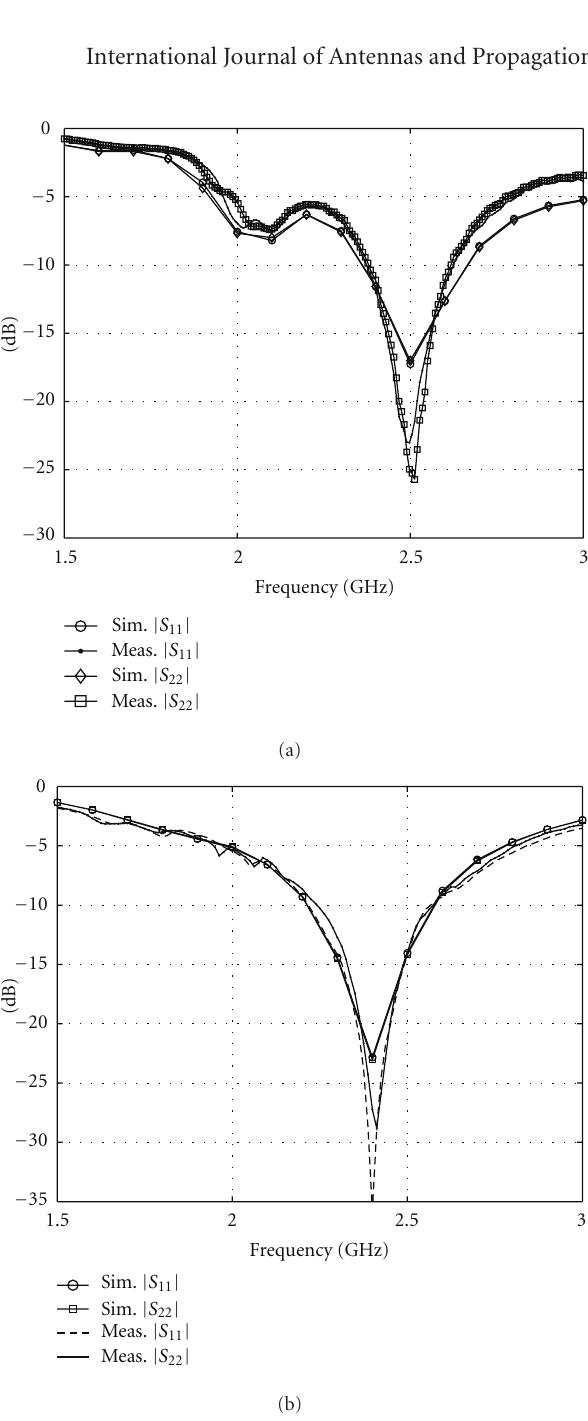
Figure 4: Simulated and measured reflection coe ffi cient for ele- ments 1 and 2 for (a) V-shaped antenna array and (b) Yagi antenna